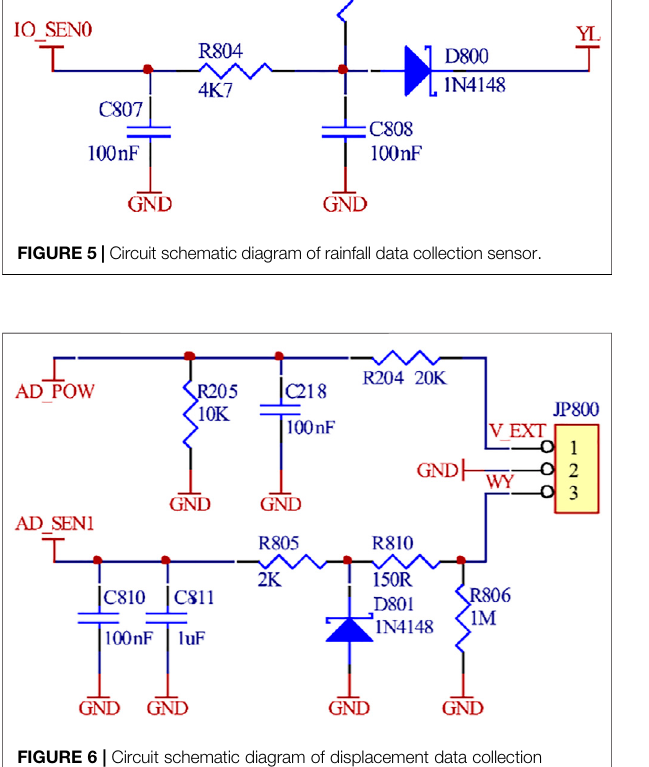
FIGURE 6 | Circuit schematic diagram of displacement data collection sensor.